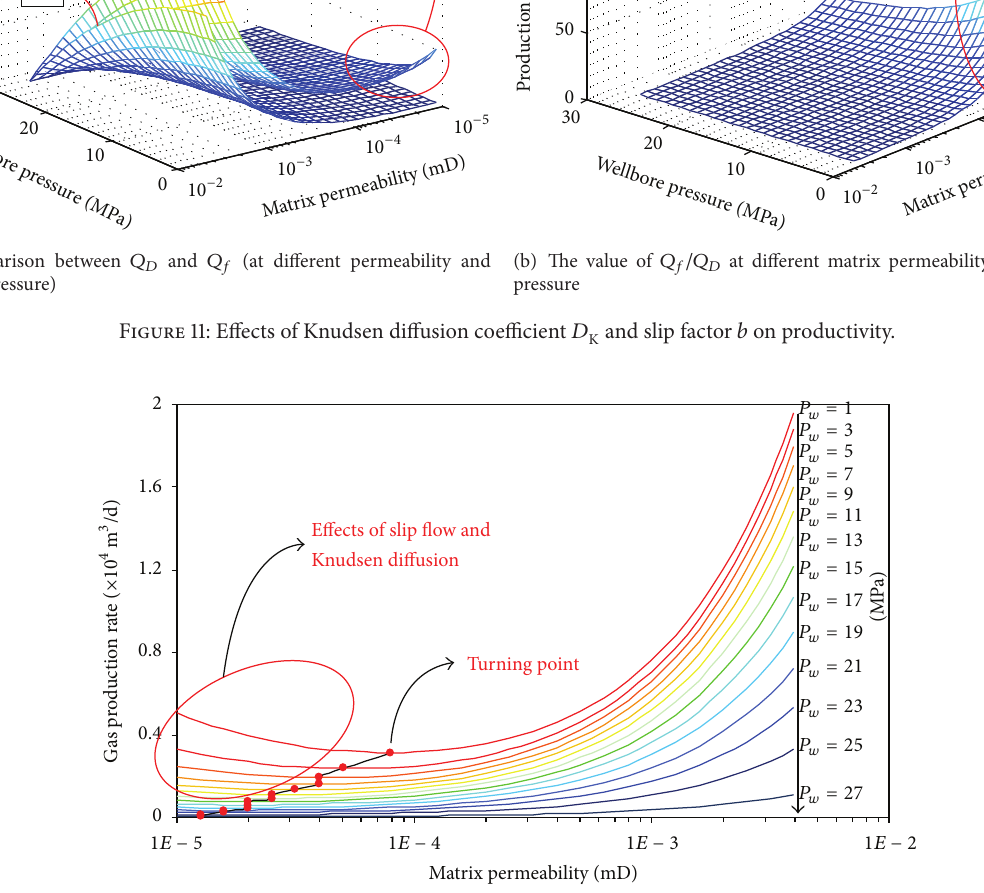
Figure 12: The relationship between gas production and matrix permeability at different wellbore